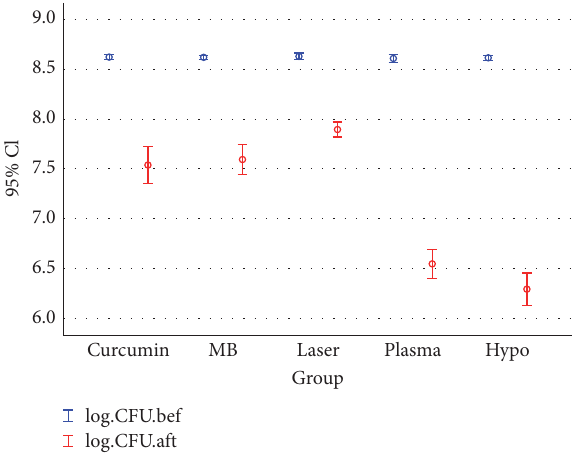
F IGURE 3: Colony count of the groups before and after the intervention (log CFUs/mL).